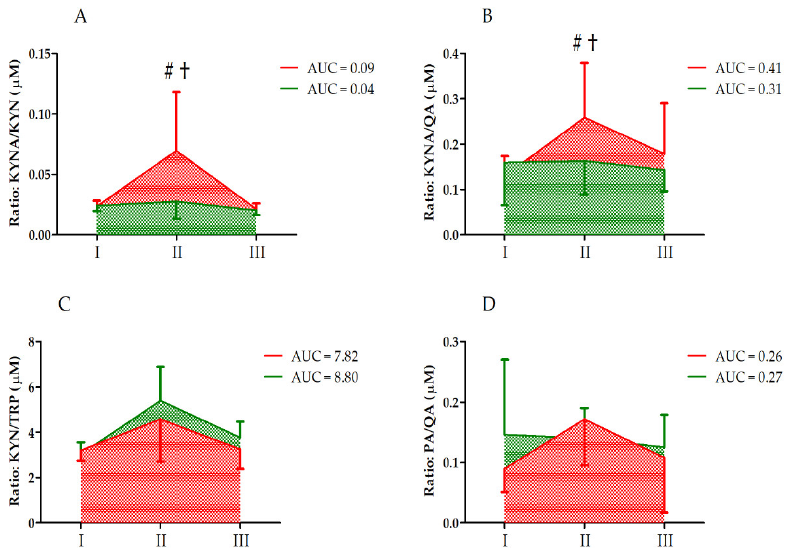
Figure 3. Changes in KYN metabolite and TRP ratios after the ultramarathon in runners who received a single high dose of vitamin D (supplemented group , green) and runners who received the placebo (control group, red). Sampling: I, 24 h before the run; II, immediately after the run; and III, 24 h after the run. ( A ) KYNA/KYN, kynurenic acid to kynurenine ratio; ( B ) KYNA/QA, kynurenic acid to quinolinic acid ratio; ( C ) KYN/TRP, kynurenine to tryptophan ratio; ( D ) PA/QA, picolinic acid to quinolinic acid ratio. †, Significant difference vs. 24 h before and 24 after the run; #, significant difference vs. supplemented group immediately after the run. The significance level was set at p <